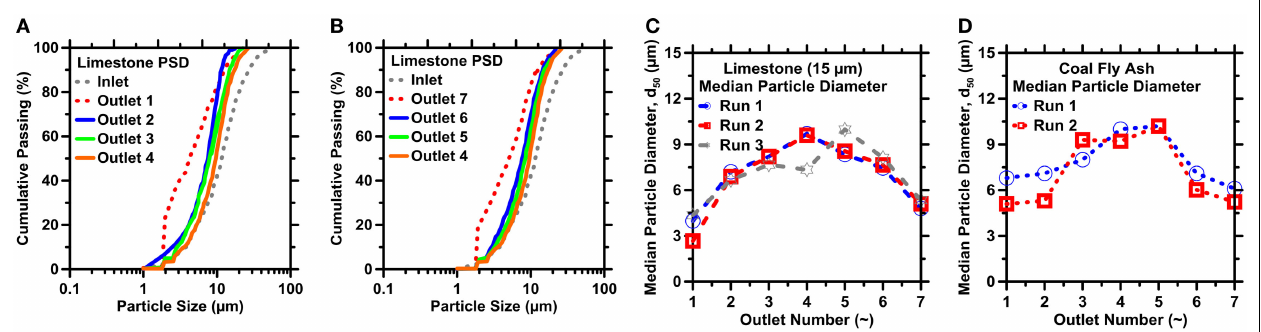
as retrieved from different outlets. The uncertainty in the d 50 values, hence the particle sizes, as determined from ICA on replicate images is on the order of 7% for limestone and 16% for coal fly ash, respectively.